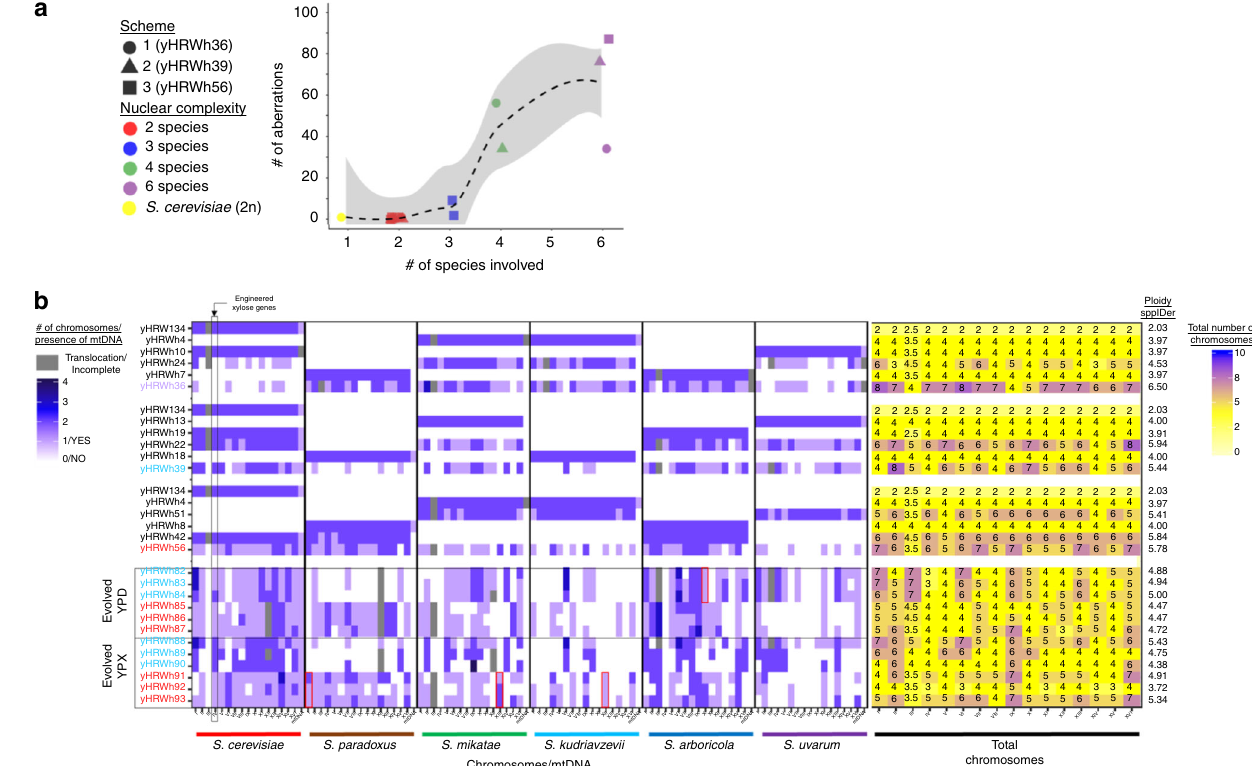
Fig. 2 Genome contributions to synthetic hybrids. The numbers and sources of chromosomes for each synthetic hybrid were inferred from sppIDer plots (Supplementary Fig. 3), which were corrected based on fl ow cytometry ploidy estimations. a The number of chromosomal aberrations was inferred for each synthetic hybrid as new translocation, gain, and loss events not seen in the preceding hybrid (Supplementary Fig. 3). Chromosomal aberrations involving parts of chromosomes were conservatively counted only in cases of clear fusion of entire arms, whereas smaller loss-of-heterozygosity events were not counted. The synthetic hybrids generated from each independent scheme are represented with different shapes. Color points are colored according to the number of species genomes contributing to the strain. A LOESS regression line and the 95% con fi dence interval of the fi t are represented with a discontinuous black color and gray shadow, respectively. b Chromosome content is colored according to the species donor. Mitochondrial inheritance was inferred using mitosppIDer (Supplementary Fig. 4). The numbers of chromosomes for each species are colored according to the left heatmap legend. Incomplete and recombinant mtDNA are colored in gray. Total number of chromosomes is shown in the right part, which is colored according to the right legend. Ploidy estimates based on de novo genome assemblies, which correlates with fl ow cytometry (Spearman rank-sum test R = 0.88, p value = 7.5 × 10 − 8 , Supplementary Fig. 5c), are indicated at the right side. Synthetic hybrids are reported in the order constructed (Supplementary Fig. 2). yHRW134 and yHRWh4 are shown multiple times because of their use in multiple crossing schemes. Evolved hybrids are grouped based on the conditions in which they were evolved, and they are colored according to their ancestor hybrid. Red squares highlight chromosomes that were retained or lost in all hybrids evolved in the same condition when compared to their siblings evolved in the other condition. S. cerevisiae chromosome IV, where the xylose utilization genes were inserted, is indicated by the black square. Considerable karyotypic diversity continued to be generated during 80 generations of ALE (Fig. 6), but each evolved strain is easily recognized as more similar to its ancestor six-species hybrid. Source data are provided in the Source Data fi le and at